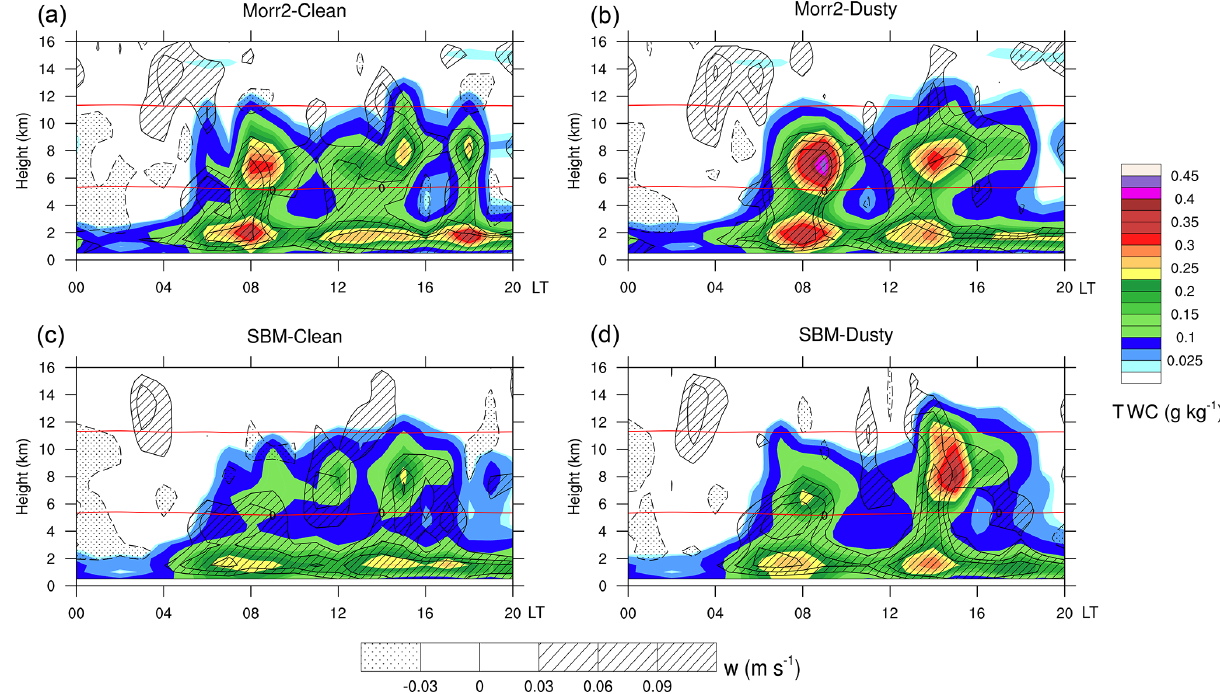
Figure 5. (a–d) Time series of total water content (TWC; shaded) and vertical velocity (contours) averaged among rainfall grids ( > 0mmh − 1 ) in the High-Pcp area for model simulations of Morr2-Clean, Morr2-Dusty, SBM-Clean, and SBM-Dusty, respectively. The two red lines denote the temperature of 0 and − 38 ◦ C.